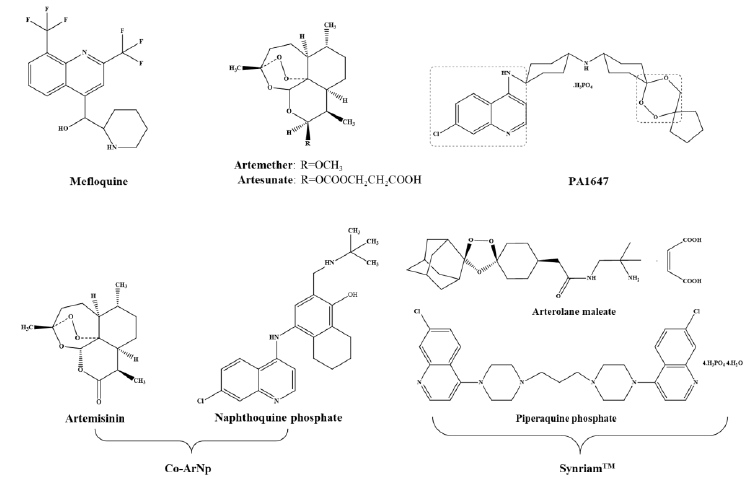
Figure 3. Antimalarials studied alone or in combined regimen on experimental infections and clinical trials. PA1647 and Synriam TM are trioxaquines and trioxalanes respectively. Note that PA1647 contain two antimalarial pharmacophores: a 4-aminoquinolone and a 1,2,4-trioxane.